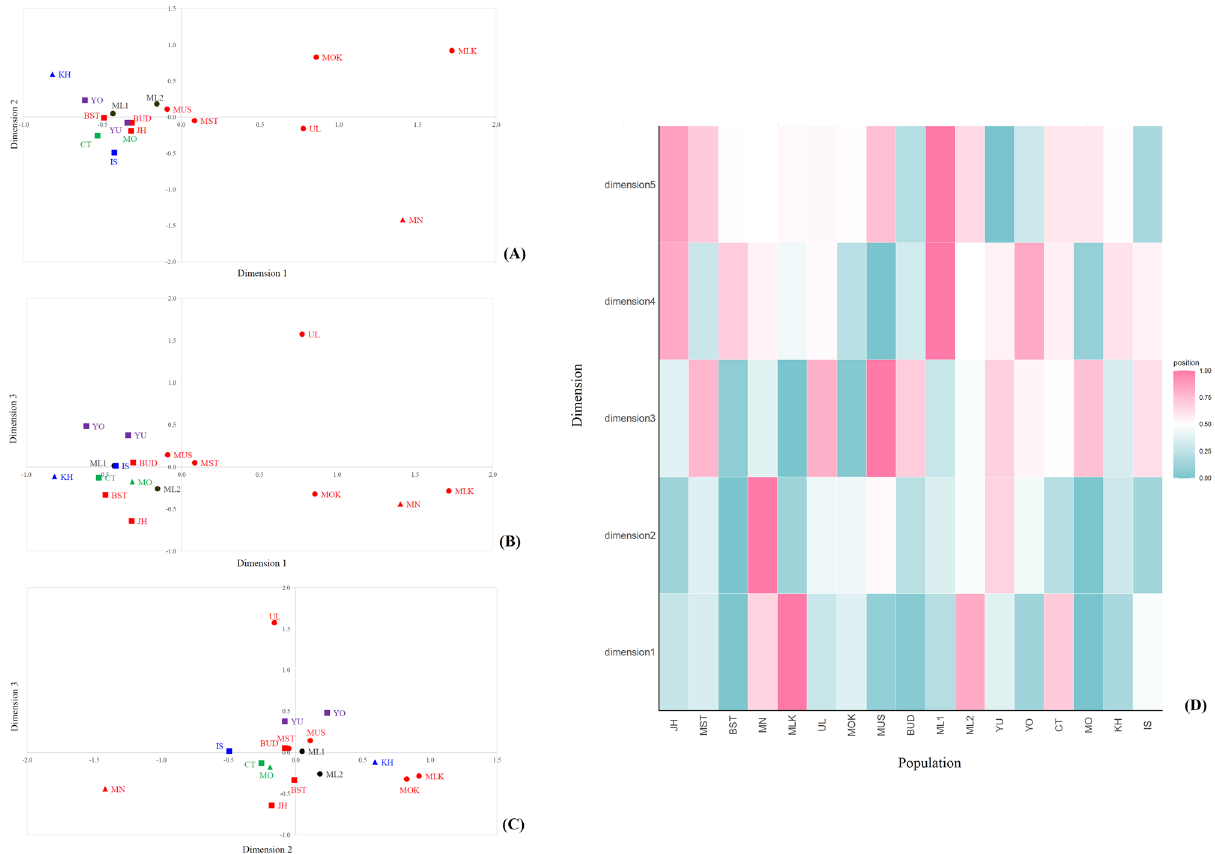
Figure 2. The three-dimensional MDS plots for 17 populations ( A – C ) (stress = 0.0030) and the heat plot of standardized values of MDS with five dimensions (D). See population abbreviation in Table 1. Red, purple, green, blue and black indicate populations from southern Thailand, northern Thailand, northeastern Thailand, central Thailand and Malaysia, respectively. Circle, square and triangle indicate Austronesian, Tai-Kadai, Austroasiatic families,